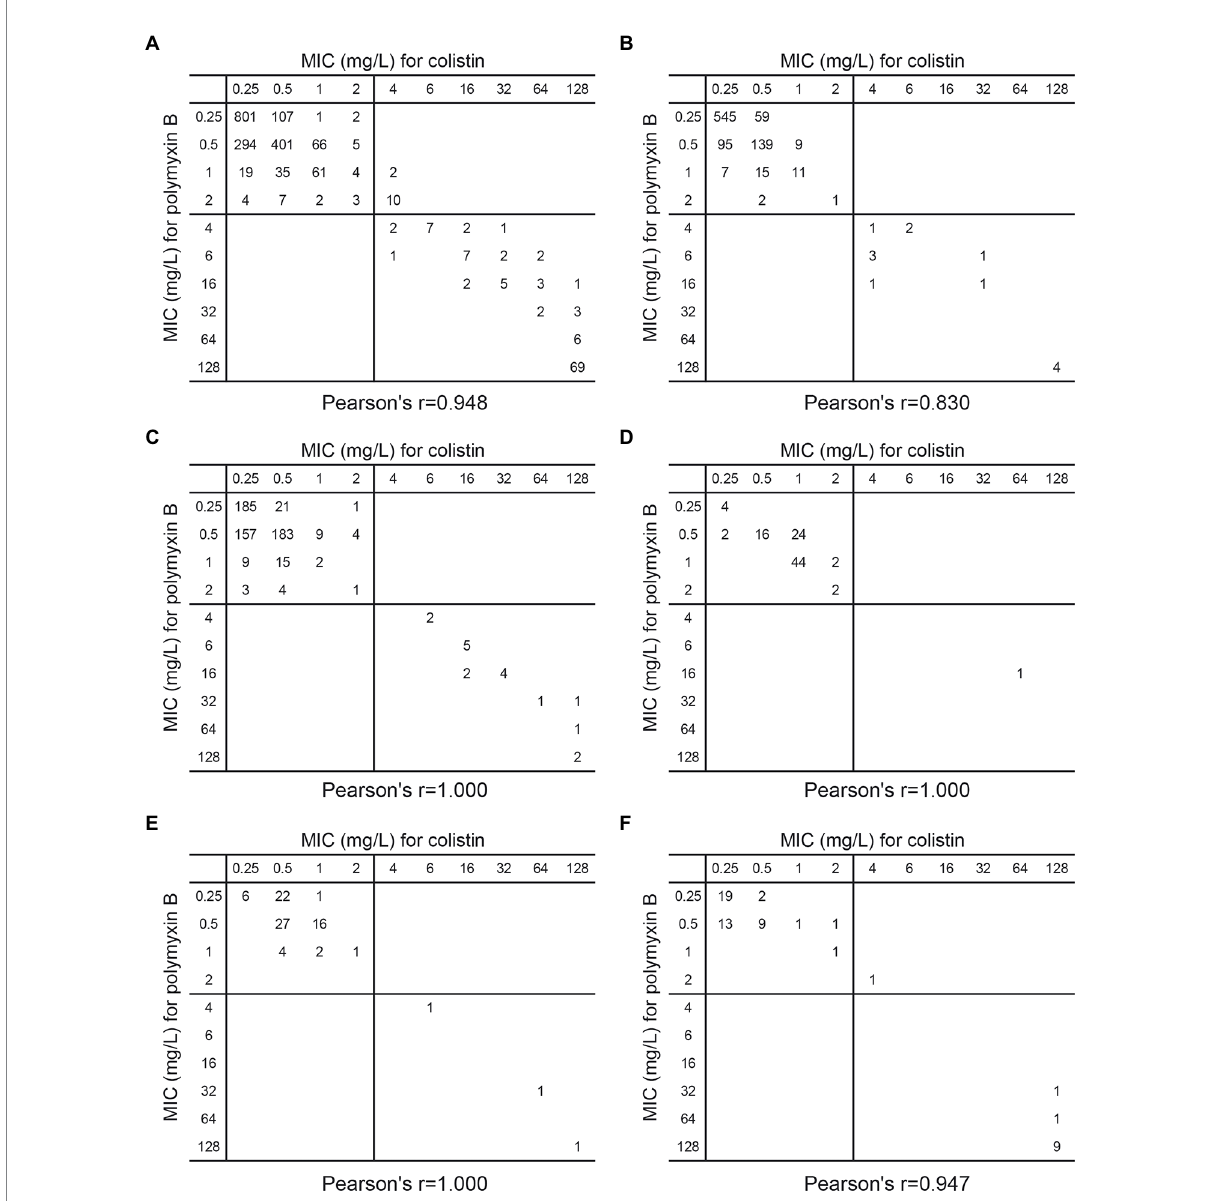
FIGURE 3 Scatterplot of MIC (mg/l) of colistin versus polymyxin B against (A) 1,939 Gram-negative bacteria (B) 896 E. coli (C) 612 K. pneumoniae (D) 95 P. aeruginosa (E) 82 A. baumannii (F) 58 E. cloacae which caused bloodstream infection in